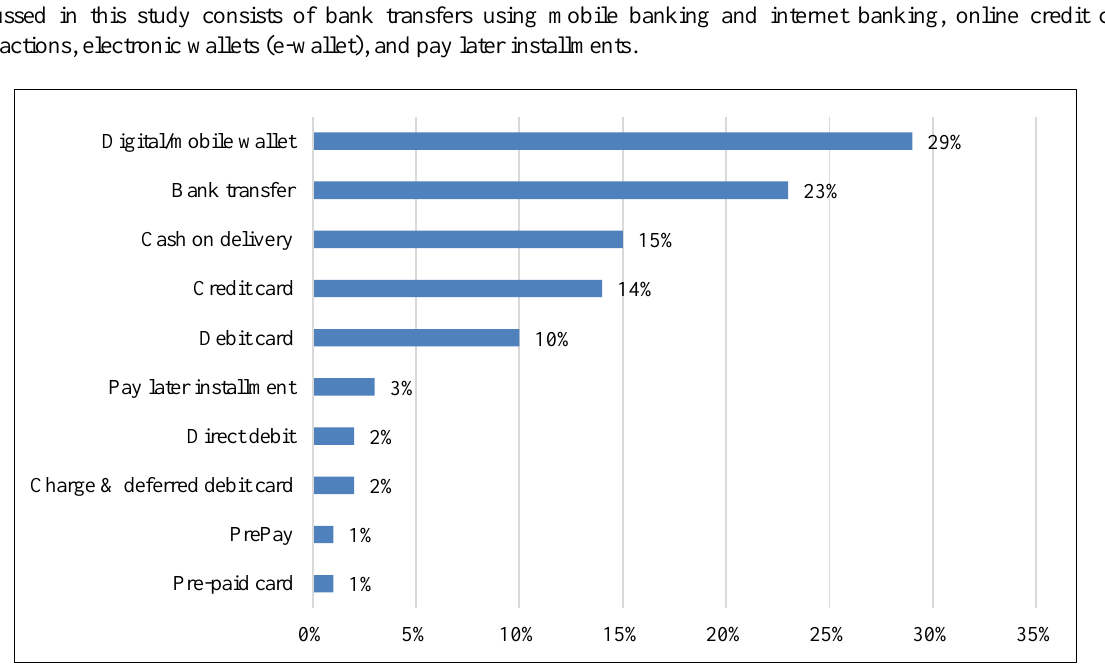
Figure 1. Distribution of e-commerce payment methods in Indonesia in